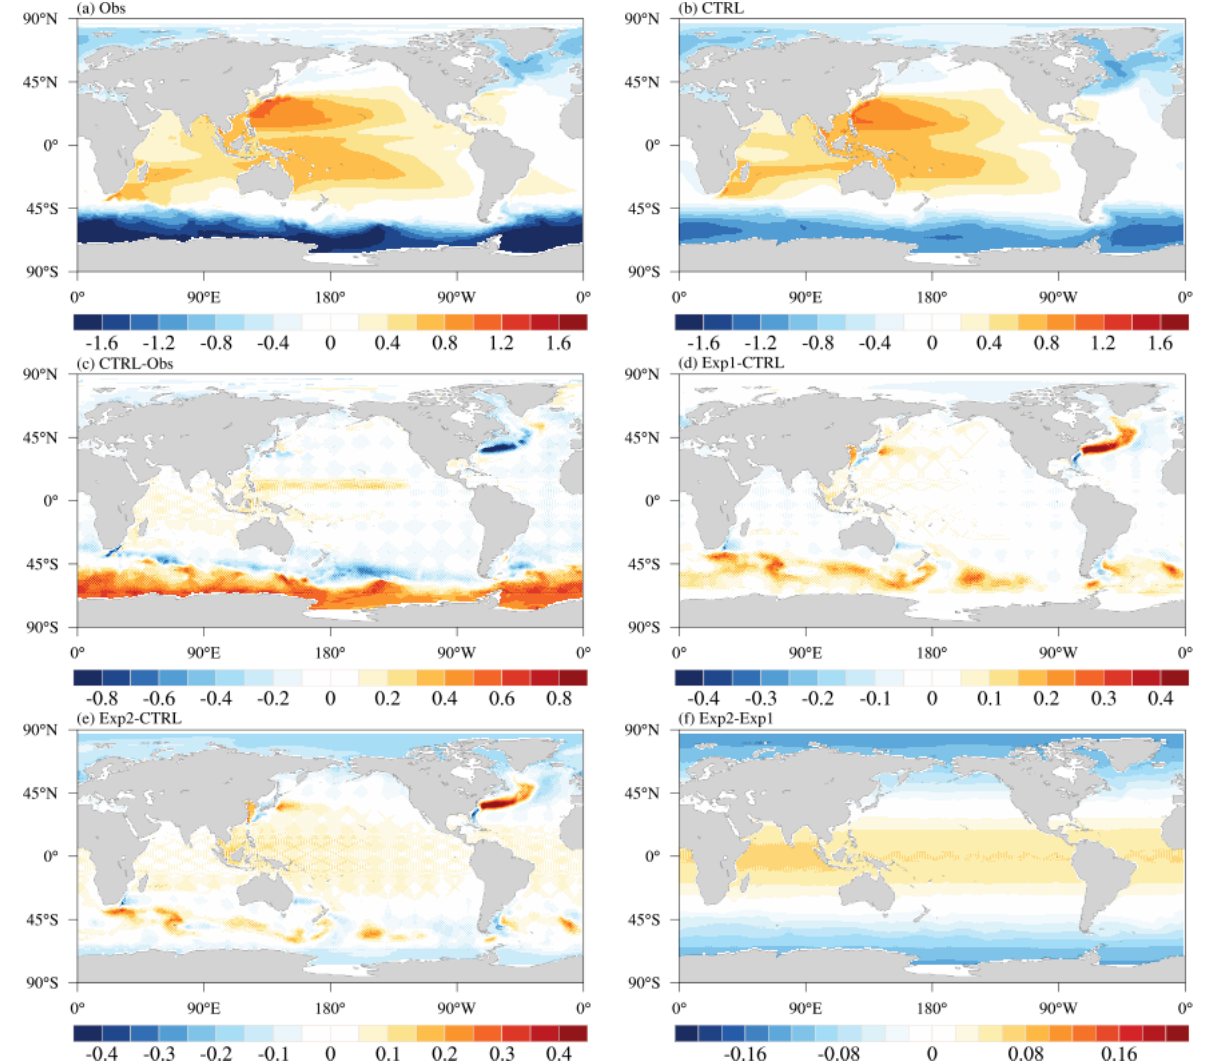
Figure 9. Spatial patterns of the dynamic sea level for (a) the observation (Obs), (b) CTRL, (c) the difference between CTRL and observation, (d) the difference between Exp1 and CTRL, (e) the difference between Exp2 and CTRL, and (f) the difference between Exp2 and Exp1. The observation is from AVISO (Schneider et al., 2013); the units are